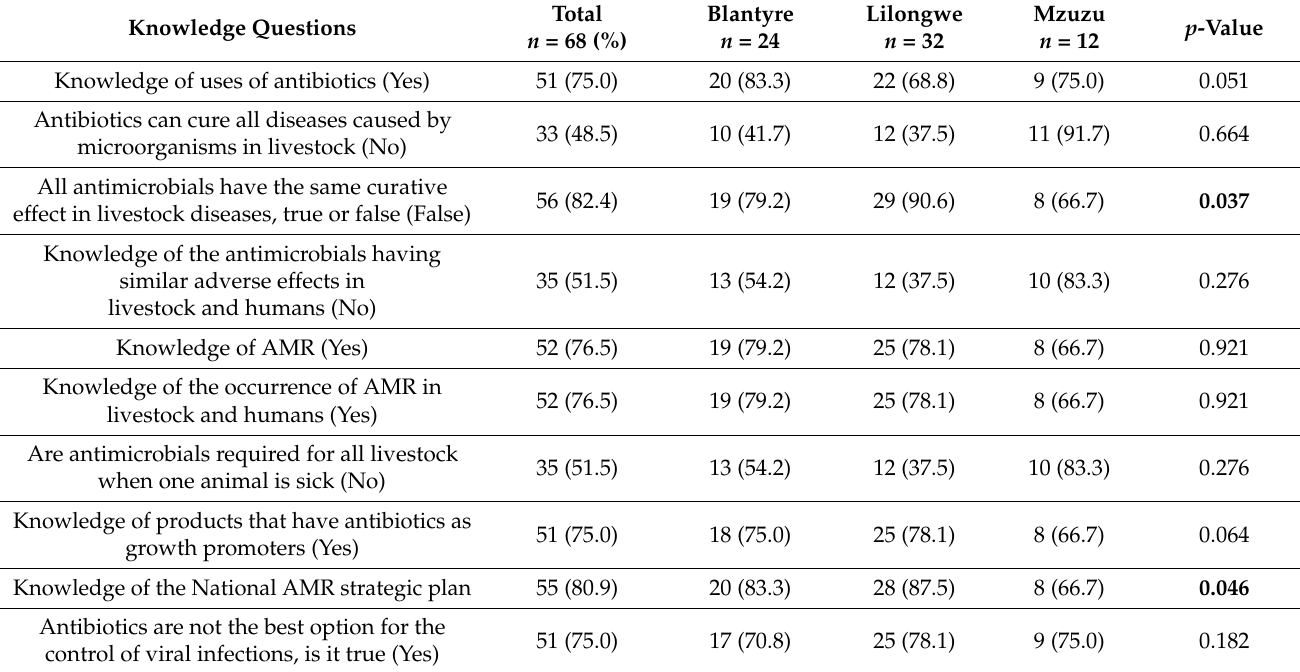
Table 2. The proportion of respondents who correctly/positively responded to knowledge questions on antimicrobial use and resistance across the study area.